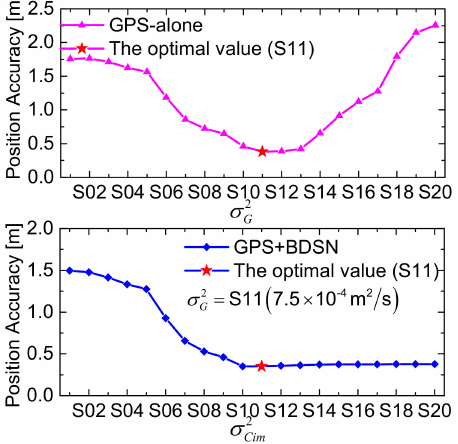
Figure 2. The real-time orbit accuracies for di ff erent σ 2 in the GPS-alone and GPS + BDSN solutions.